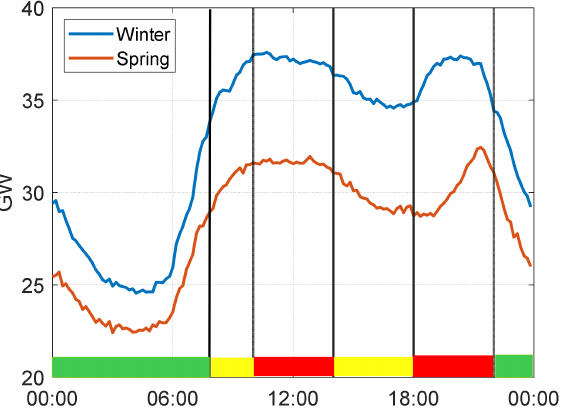
Figure 4. Load profile of Spanish electrical system on representative days (21 January 2021, 21 April 2021). The different pricing periods in tariff 2.0TD are highlighted, with the peak price periods correlated with daily maximum electricity demand